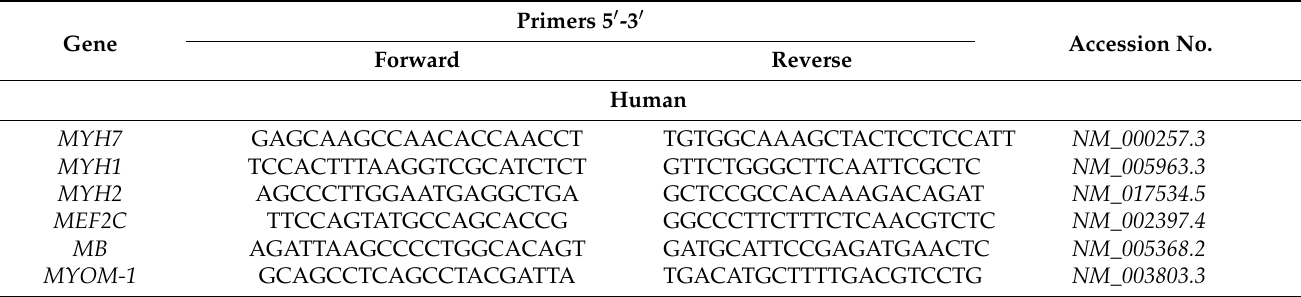
Table 1. Primer sequence used for amplification during real-time